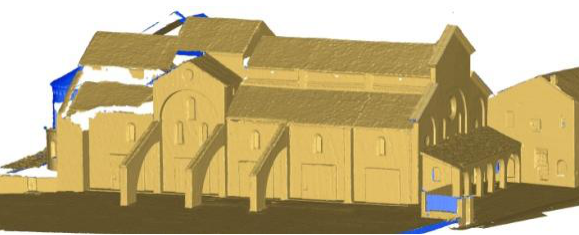
Figure 20. Final 3D model processed with “Regular Sampling” method (distance between points: 0.08 m).